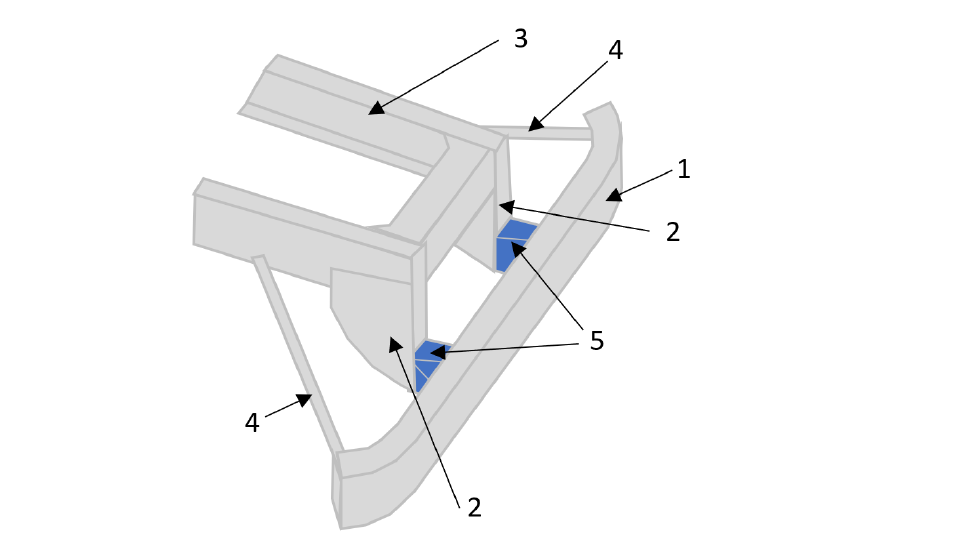
Figure 15. View of RUPD with enhanced energy-absorbing properties described in Patent Application No. DE102009036652A1. 1 — RUPD guard bar; 2 — Support members; 3 — Vehicle frame; 4 — Reinforcement bars; 5 — Energy-absorbing elements.